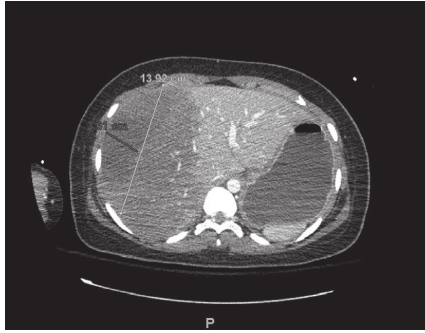
Figure 1: CTA abdomen on admission showing a large right hepatic subcapsular hematoma measuring 14 cm × 3.6cm in size with active arterial extravasation.